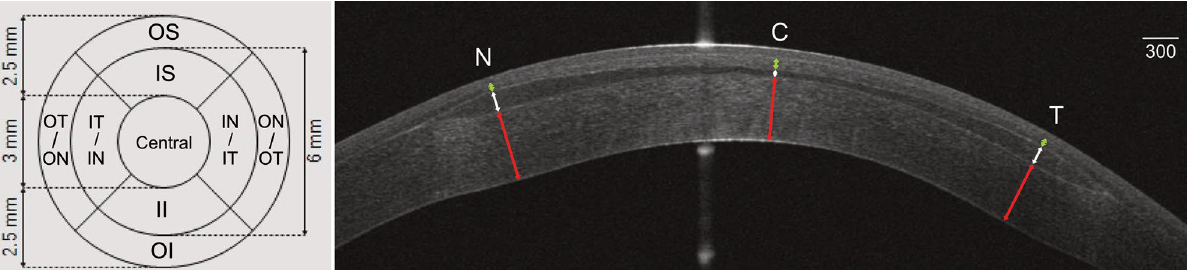
Figure 5. Epithelial sub-field map (left panel) with corresponding diameters and area acronyms ( C central, OS outer superior, IS inner superior, OT outer temporal, IT inner temporal, OI outer inferior, II : inner inferior, ON outer nasal, IN inner nasal). Horizontal OCT scan (right panel) with representation of calliper positions used for measurement of posterior stromal thickness (PST: red arrows), lenticule thickness (LT: white arrows) and anterior stromal thickness (AST: green arrows), in the central and peripheral lenticule